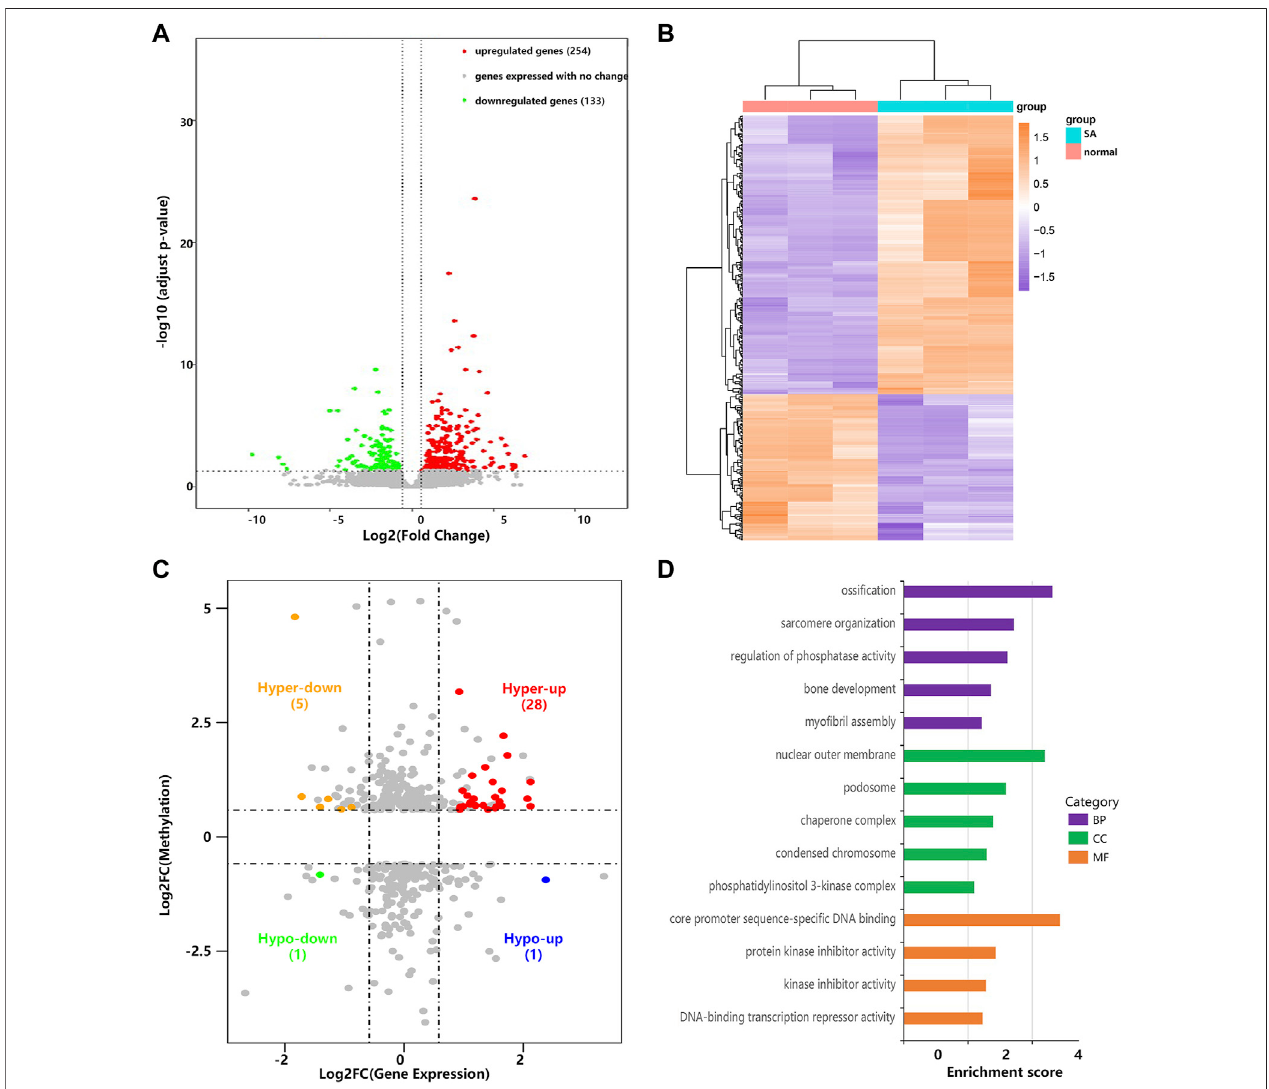
FIGURE 4 | Conjoint analysis of MeRIP-seq and RNA-seq data. (A) Volcano plots showing the differentially expressed genes in villous tissues of SA group compared with normal group. (B) Heatmap plots showing the differentially expressed genes in villous tissues of SA group compared with normal group. (C) Four- quadrantplotsshowingthedistributionofgeneswithsigni fi cantchangesinboththem 6 Amodi fi cationandmRNAlevels. (D) Thetop5GOtermsofgeneswithsigni fi cant changes in both the m 6 A modi fi cation and mRNA